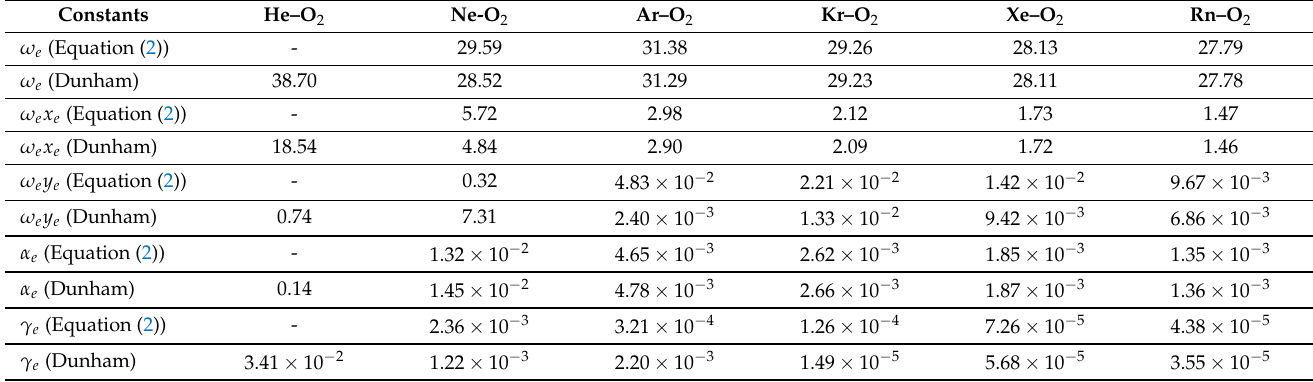
Table 5. Ng–O 2 spectroscopic constants (cm − 1 ) obtained through the ECF potential energy